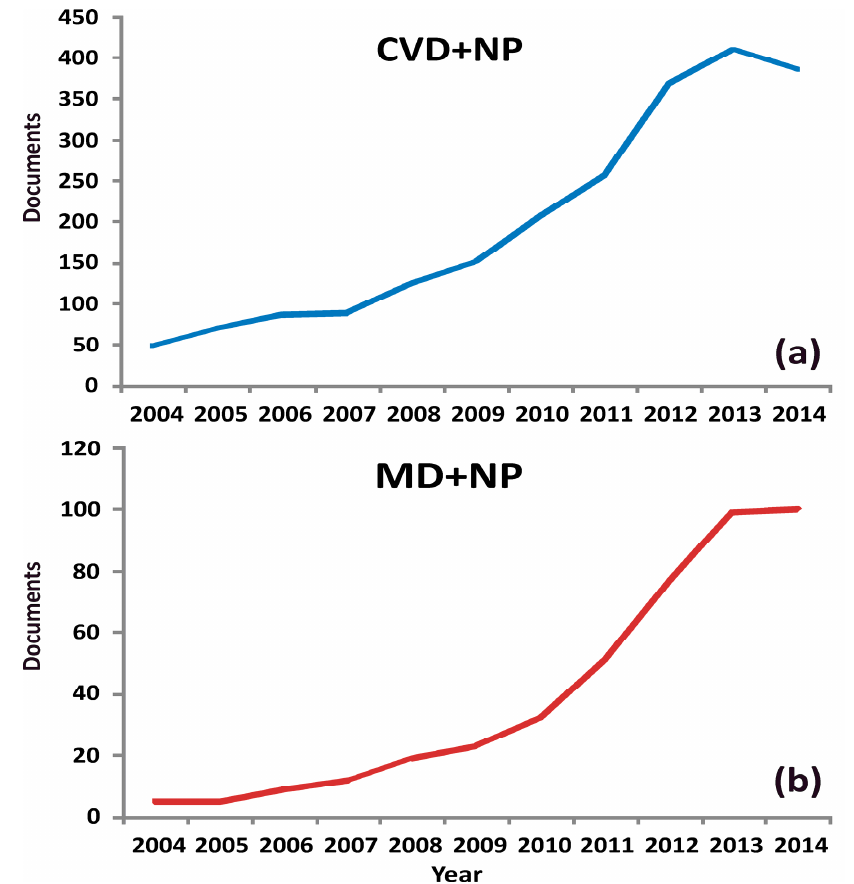
Figure 1. Annual number of publications resulting from the search with the keywords “cardiovascular disease” and “natural products” (CVD + NP) ( a ) and “metabolic disease” and “natural products” (MD + NP) ( b ), (Scopus, January 2016).